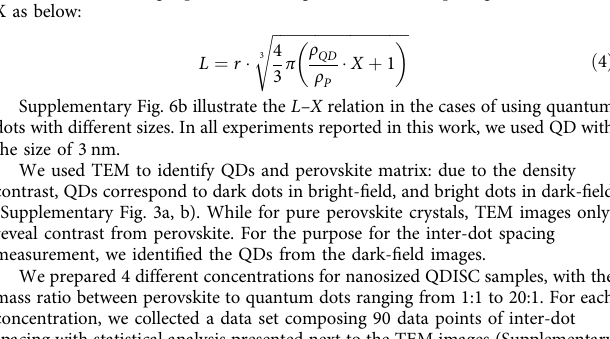
Supplementary Fig. 6b illustrate the L – X relation in the cases of using quantum dots with different sizes. In all experiments reported in this work, we used QD